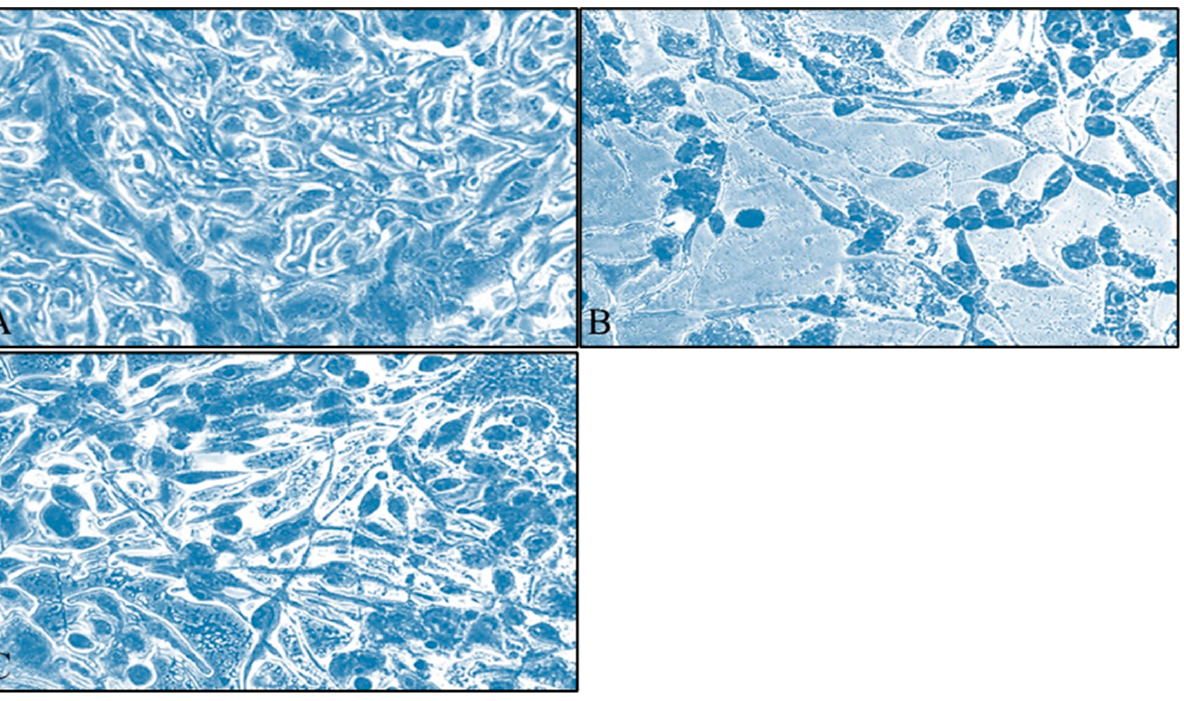
Figure 1. Dose dependent and time dependent effect after treatment with S. aspera extract on TE671 ( A ) and A172 ( B ) cells. Data are presented as the mean ± standard error of the mean (SEM) (with n = 8). The asterisk (*) indicates significant differences between untreated and treated cells. The grey color corresponds to 24 h of treatment, the pink to 48 h and the light blue to 72 h.